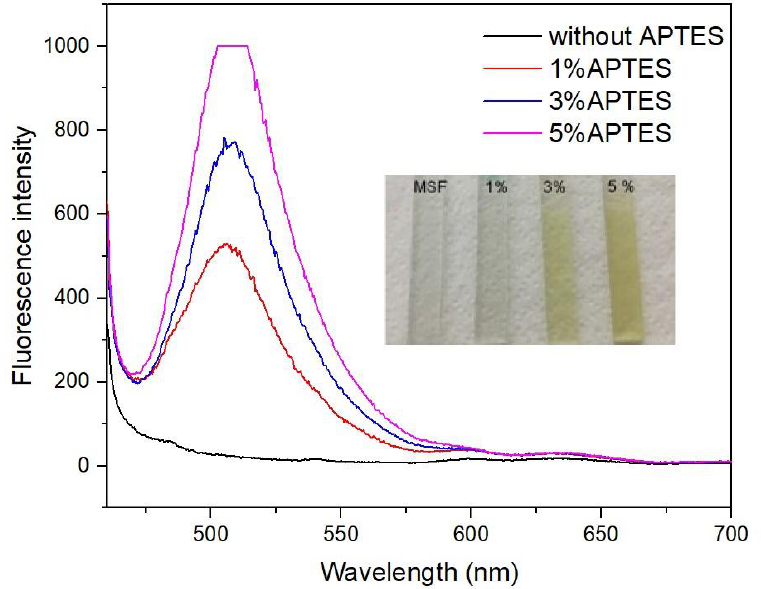
Figure 5. A picture and fluorescence spectra of Pyr immobilized on modified MSF.